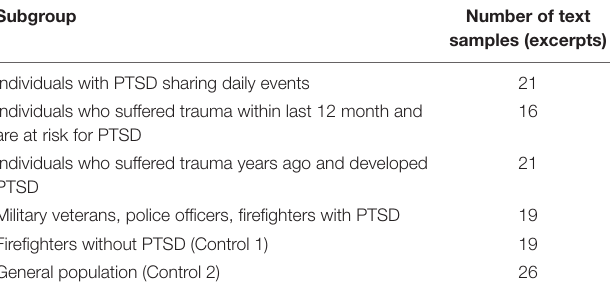
TABLE 1 | Description of PTSD subgroups and control groups for language use